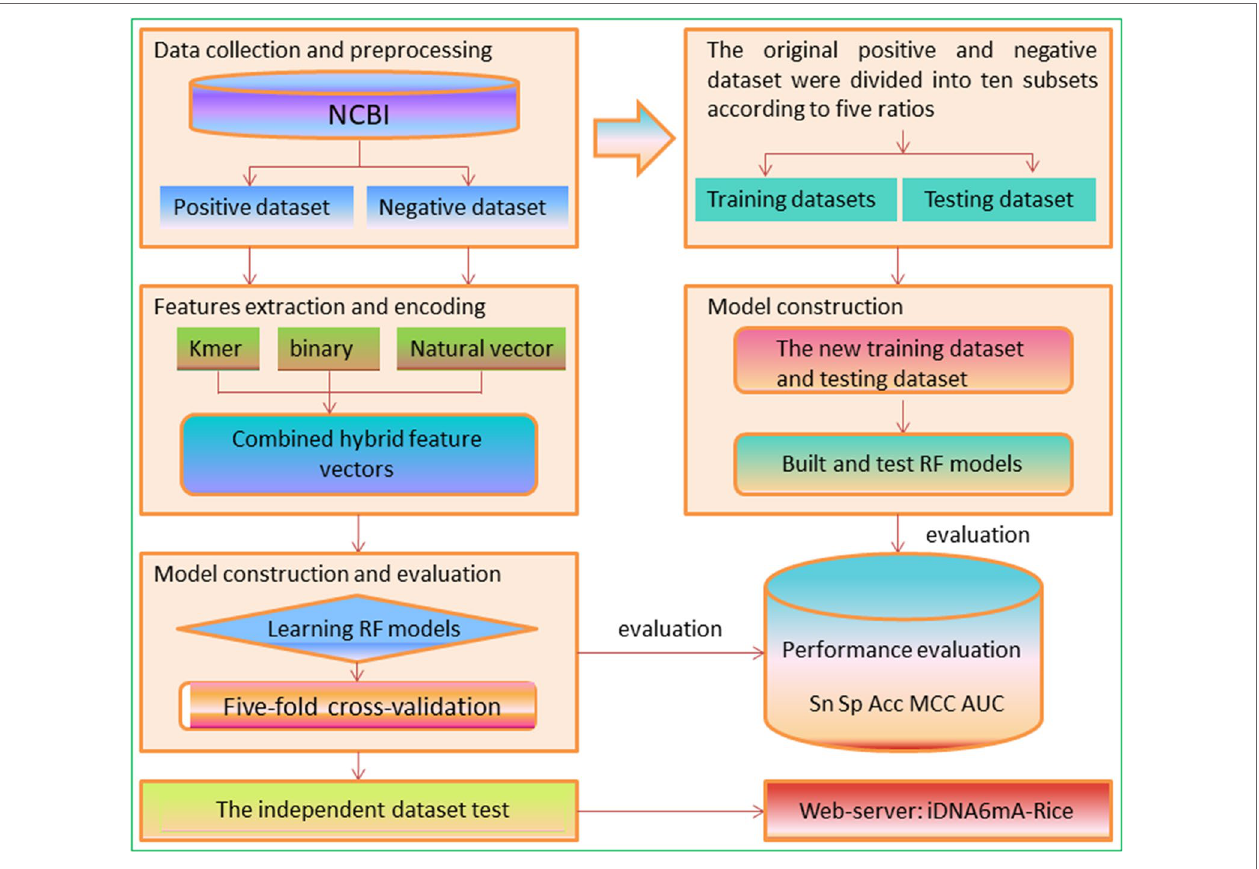
FIGURE 2 | A flowchart used in this study.